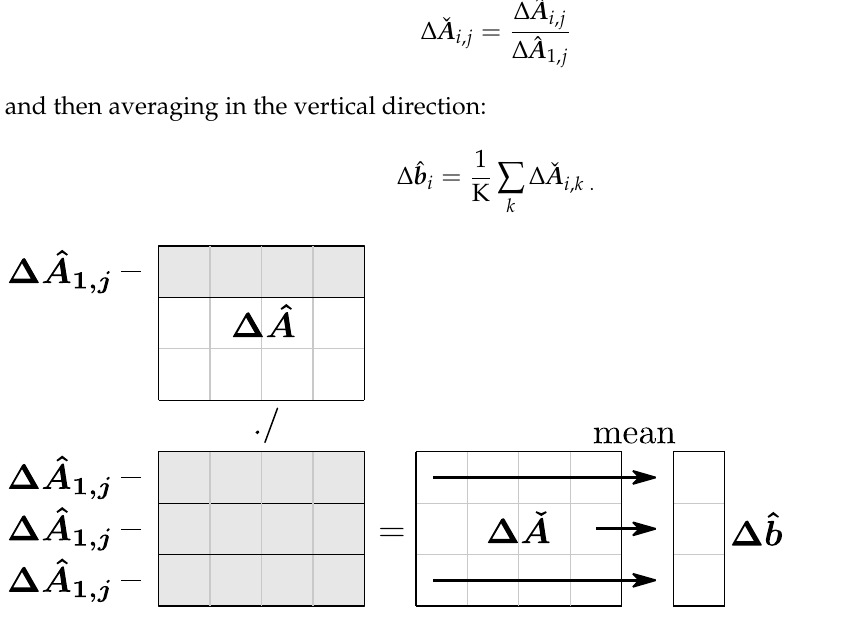
Figure 4. Normalization and averaging used to obtain estimated offsets of transmit steering vector 𝒃 .